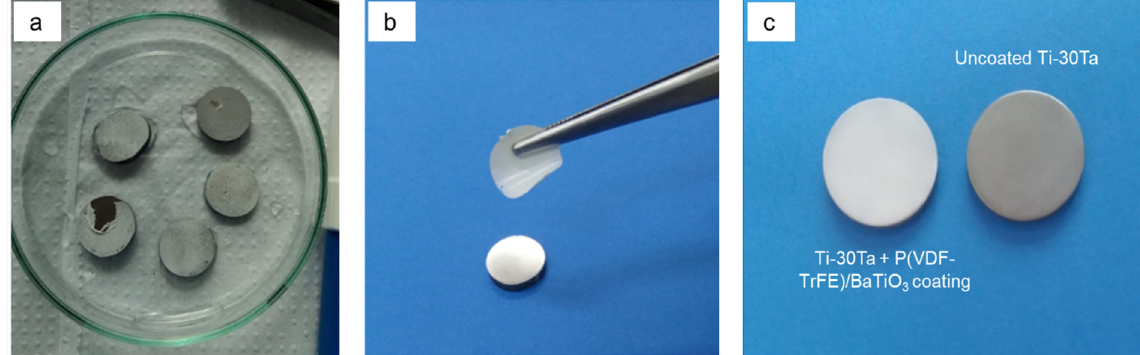
Figure 8. Study of temperature influence in the coating process: ( a ) substrate at room temperature; ( b ) substrate at 100 °C; ( c ) substrate at 150 °C.